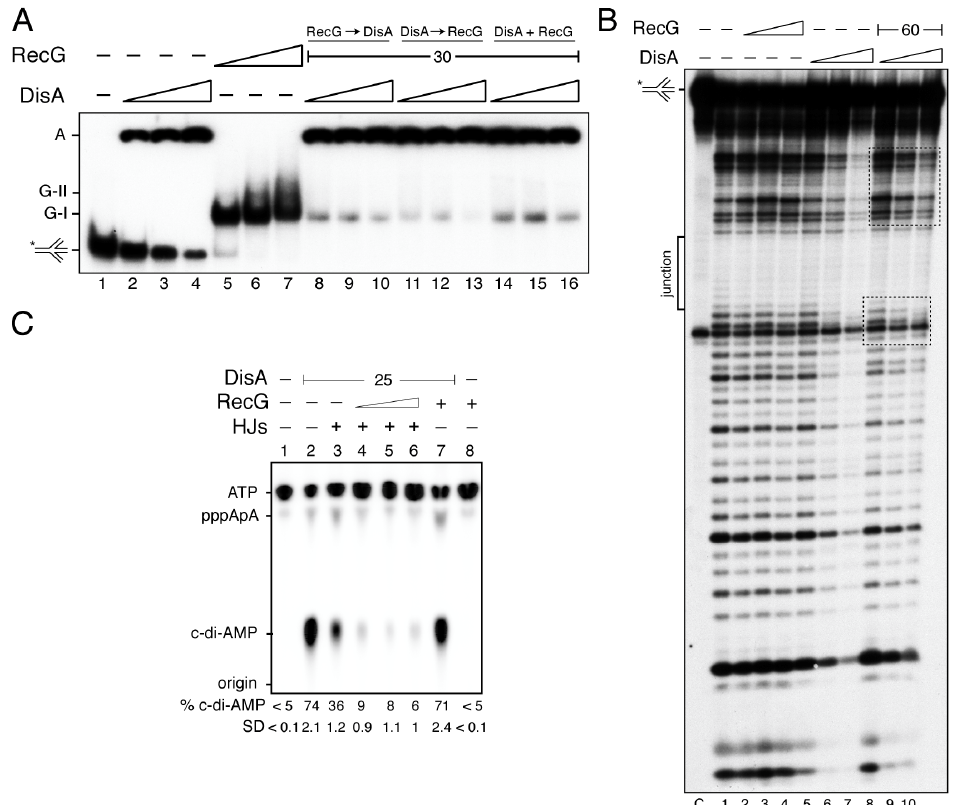
Figure 1. DisA may coexist with RecG on HJ DNA. ( A ) For EMSA assays [ γ 32 P] HJ-J3 DNA (0.1 nM in molecules) was incubated with increasing DisA (6–25 nM, lanes 2–4), RecG (7.5–30 nM, lanes 5–7) or increasing DisA and fixed RecG (lanes 14 to 16) concentrations, or pre-incubated with a fixed RecG (lanes 8–10) or increasing DisA concentrations (lanes 11–13) and then the second protein added for 15 min in buffer B containing 5 mM ATP γ S at 37 ◦ C. The protein-DNA complexes were separated using 6% PAGE in TAE buffer and visualized by autoradiography. The RecG-HJ (G-I and G-II) and DisA-HJ (A, retained in the well) complexes are indicated. ( B ) DNAse I footprinting assays. The [ γ 32 P] HJ-J3 DNA was pre-incubated with increasing RecG (15–60 nM) or DisA concentrations (30–120 nM) or increasing DisA concentrations and a fixed RecG concentration (60 nM) in buffer C containing 5 mM ATP γ S for 15 min at 37 ◦ C, and then DNAse I was added. Samples were separated in 15% dPAGE and autoradiographed. The region protected by DisA in the presence of RecG is marked with rectangles. C denotes a HJ DNA control without DNase I treatment. In (A,B) the assay was repeated >3 times with similar results, a representative gel is shown. (C) RecG bound to HJ DNA inhibits DisA-mediated c-di-AMP synthesis. DisA (25 nM) was incubated in buffer E containing 100 µ M ATP in the presence of HJ-J3 DNA (125 nM) and increasing RecG concentrations (7 to 30 nM ) for 30 min at 37 ◦ C. Samples were separated by TLC, dried and visualized by phosphor imaging. Spots corresponding to the ATP and c-di-AMP molecules were quantified. The position of ATP, the linear pppA-pA intermediate, c-di-dAMP and the origin are indicated. A representative gel and the mean ± SD of >3 independent experiments are shown. The radiolabeled strand is indicated with an asterisk.